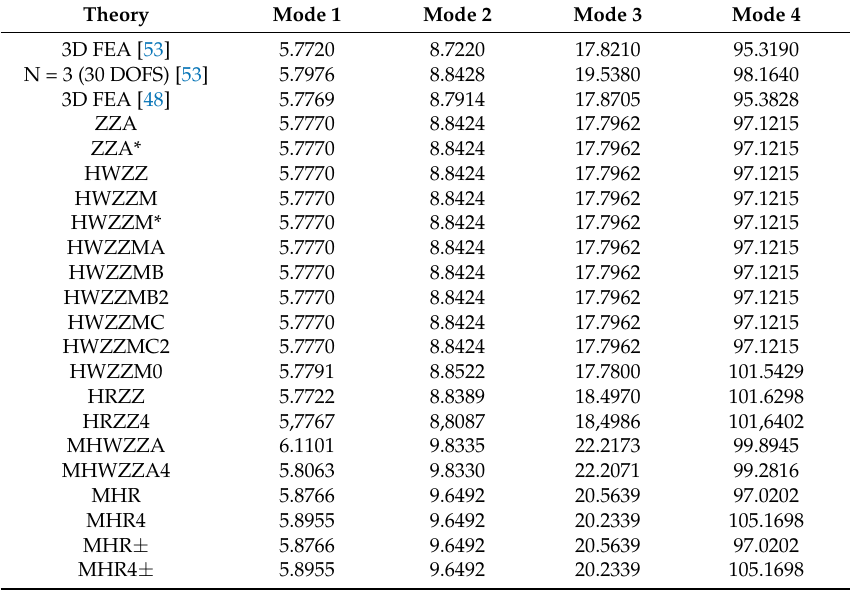
Table 17. Normalized fundamental frequencies, case